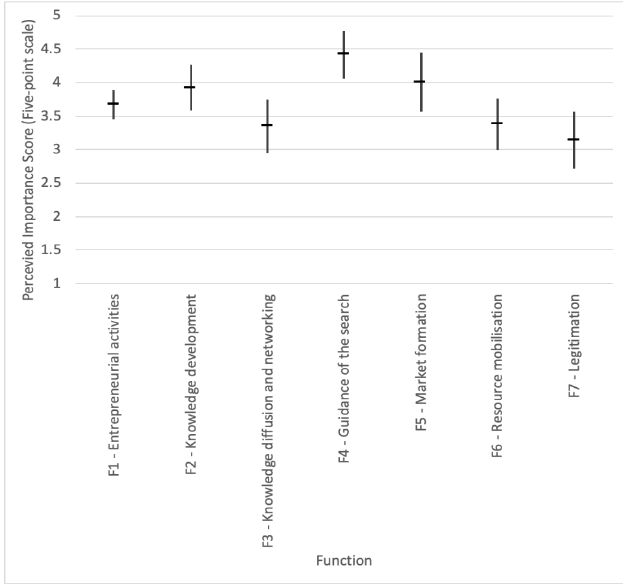
Figure 1. Mean and error bars (+/− 2 s.e.) for “perceived importance” of functions to the emergence of offshore renewable energy as scored by interviewees on a five-point Likert scale where 1 = “very unimportant” and 5 = “very important” (authors’ analysis).